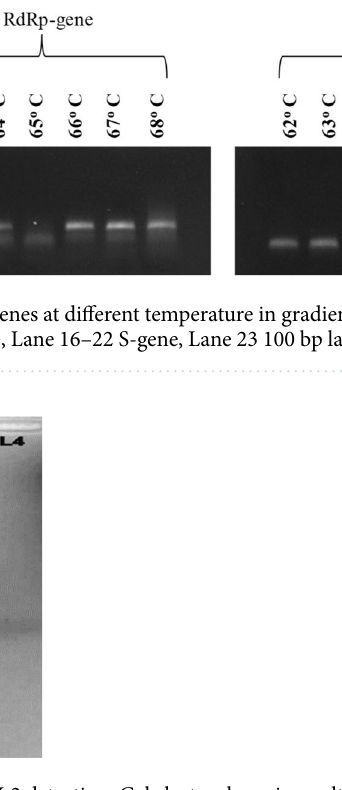
Figure 2. Fast PCR protocol for SARS-CoV-2 detection. Gel electrophoresis results from PCR (35 cycles) showing amplification of RdRp-Gene (Lane-2, L2), S-Gene (Lane-3, L3) and E-gene (Lane-1, L1), and Negative Control (Lane-4, L4) respectively. Ladder used 50 bp DNA ladder (Promega, Cat. No: